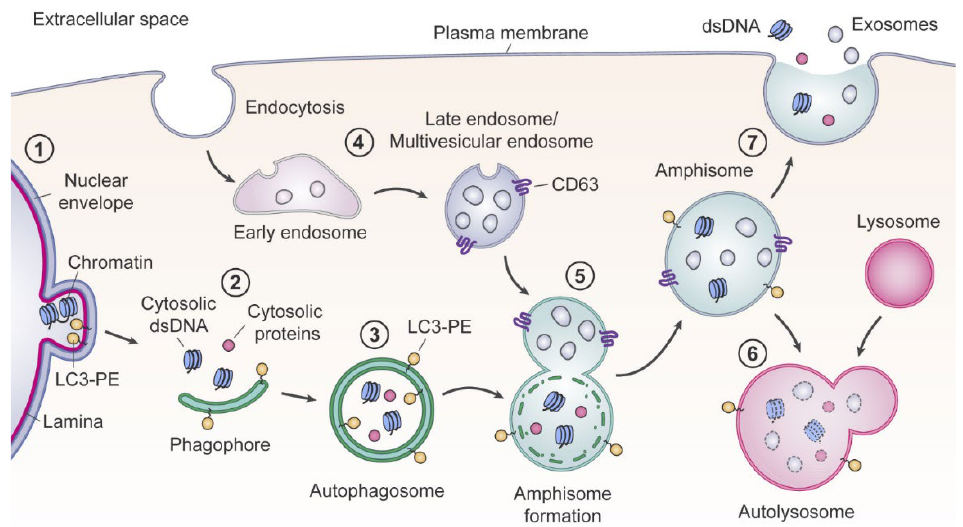
Figure 1. Jeppesen et al. model of amphisome-dependent, exosome-independent secretion. For autophagy, cytosolic LC3 is lipidated by conjugation with phosphatidylethanolamine to form LC3-PE. (1) Nuclear membranes can bleb in a process dependent on LC3B and the nuclear lamina protein Lamin B1, causing the appearance of cytoplasmic chromatin fragments. (2) During autophagy, cytoplasmic components are sequestered as a phagophore begins to engulf material. (3) Continued expansion of autophagic membranes requires LC3-PE and results in formation of the double-membrane autophagosome. (4) As early endosomes develop to late endosomes, the pH decreases and continued invagination of limiting membranes generates intraluminal vesicles (ILVs). A fully developed CD63-positive multivesicular endosome (MVE) contains numerous ILVs. (5) Fusion of the autophagosome with a MVE causes degradation of the inner autophagosome membrane, generating an amphisome, a single-membrane hybrid compartment. (6) The amphisome fuses with a lysosomal compartment to form the autolysosome followed by degradation of cargo, or alternatively, (7) the amphisome fuses with the plasma membrane causing extracellular release of dsDNA and histones, and separately, the ILVs as exosomes. Reprinted with permission from Ref. [31]. Copyright 2019, with permission from Elsevier.